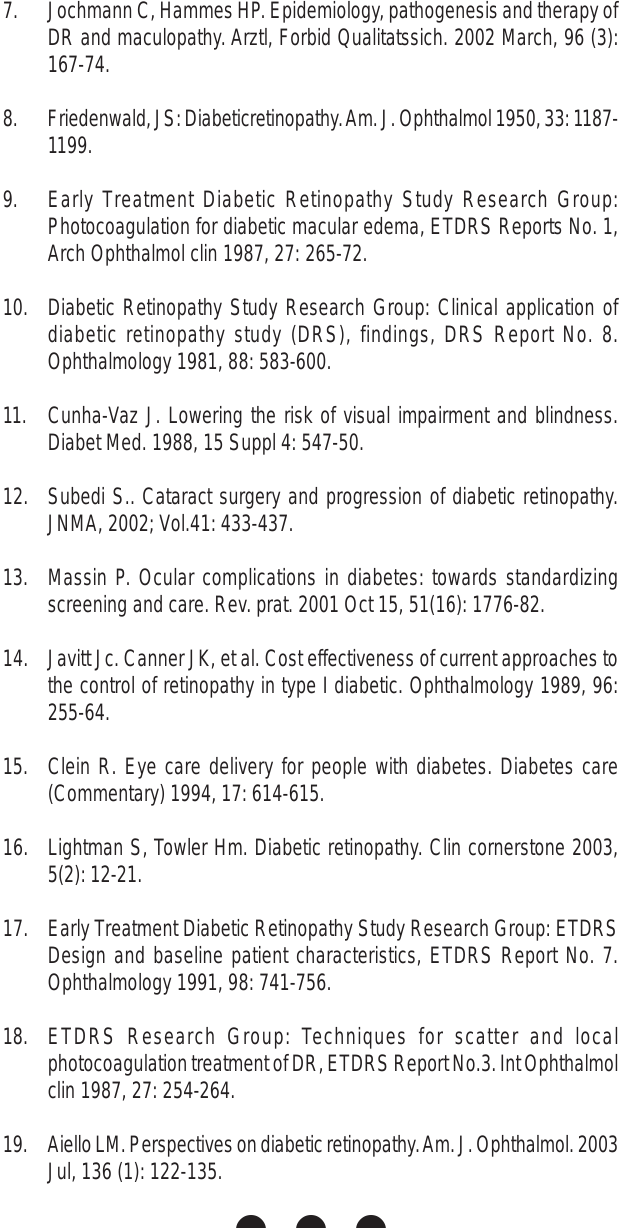
Table III : Recommended Follow up Schedule in